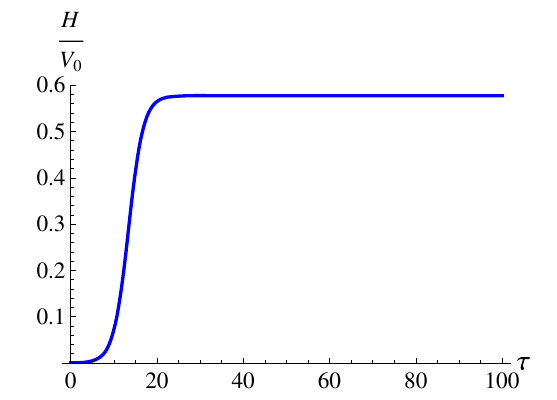
Fig. 8 Thediagrampresentstheevolutionof H / V 0 inthepoleinflation model for an example value of n = − 1. The dimensionless time τ is equal to V 0 t . Here, τ = 100 corresponds to the end of the inflation period ( t = 10 − 32 s)